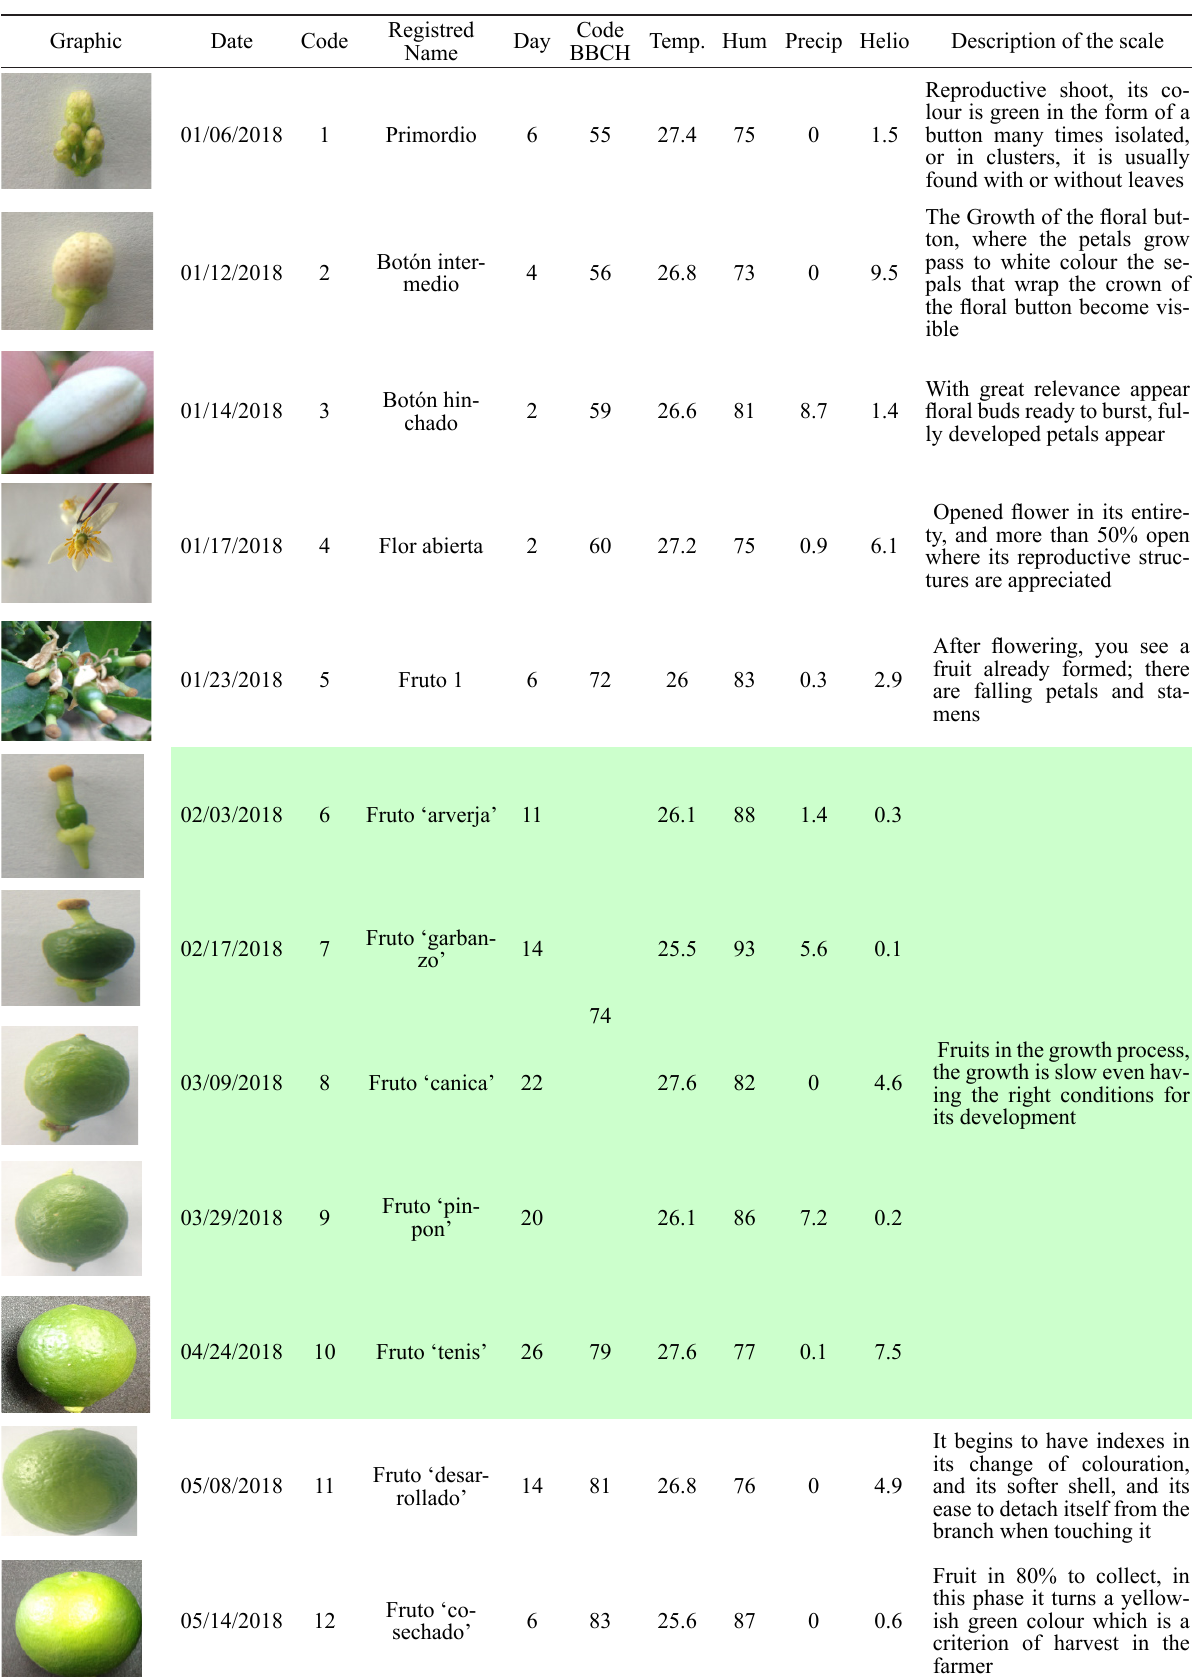
Table 2. Reproductive phenology scale of the subtle